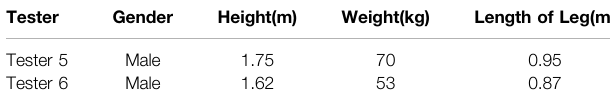
TABLE 8 | Physical characteristics of testers.